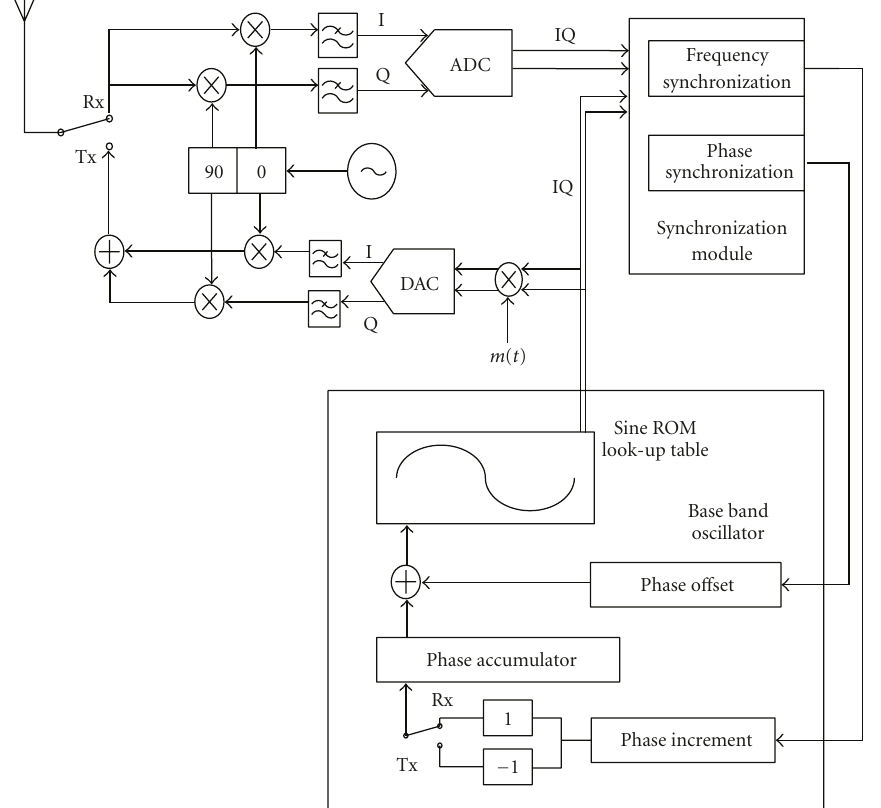
Figure 3: The transceiver uses a baseband oscillator to control the RF signal indirectly.